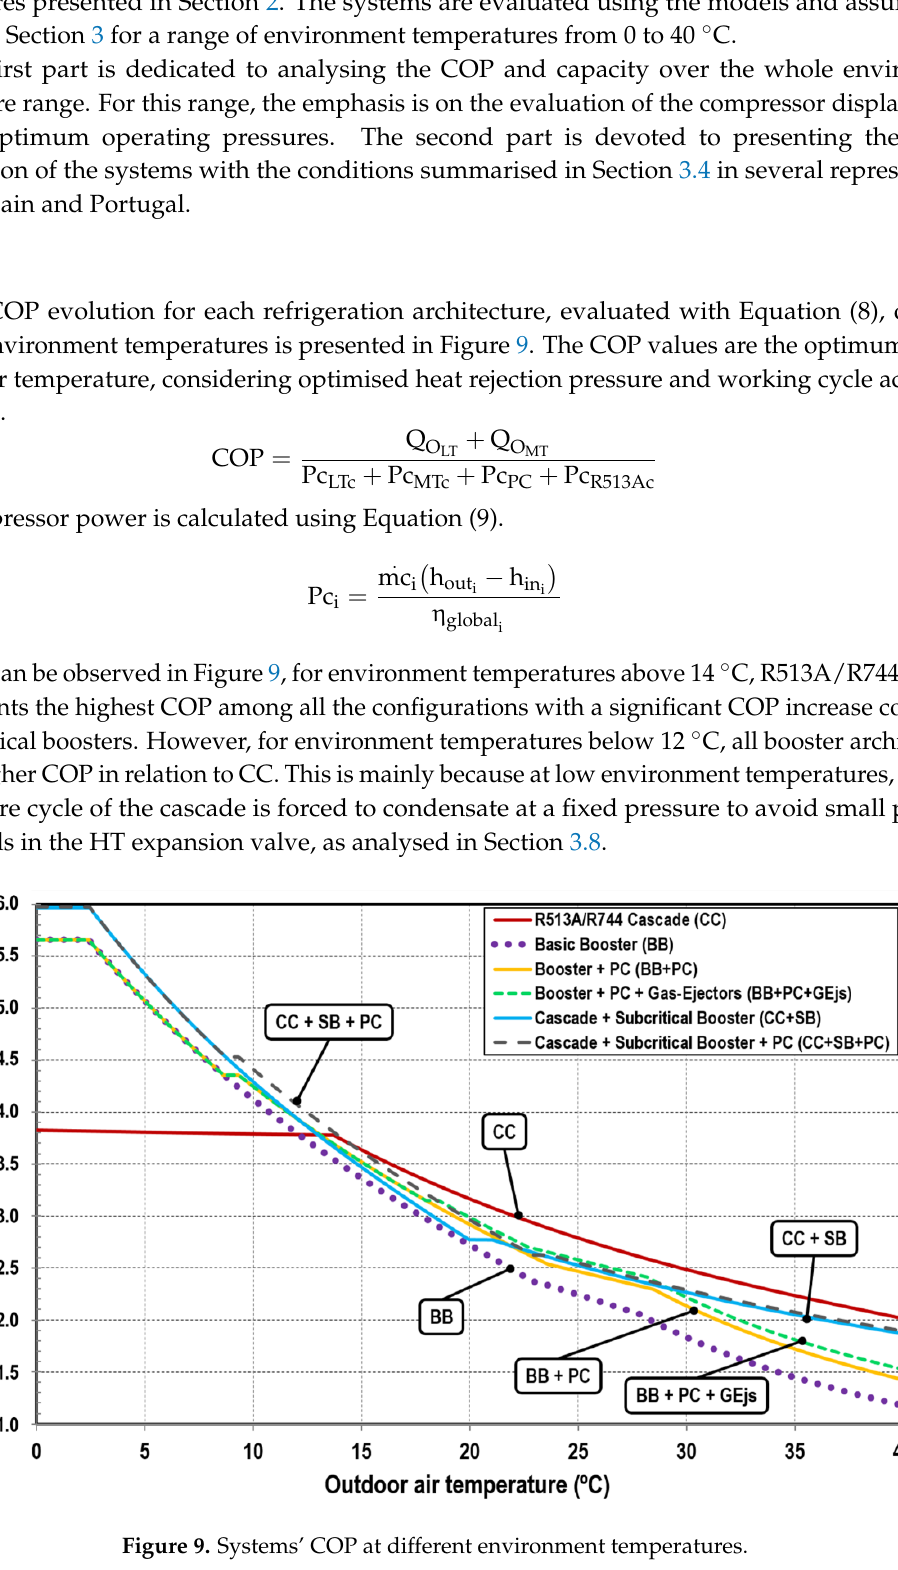
(11) Figure 10. COP increment of each system with respect to R513A/R744 cascade.